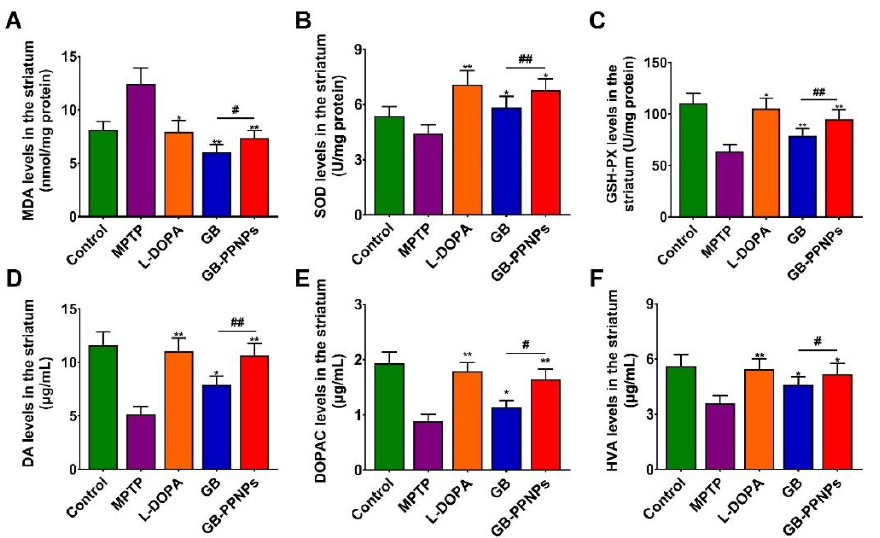
Figure 8. The impact of GB-PPNPs on striatal. The levels of ( A ) MDA, ( B ) SOD, ( C ) GSH-Px (means ± SD, n = 4), ( D ) dopamine, ( E ) DOPAC, and ( F ) HVA ( n = 7). * p < 0.05 and ** p < 0.01 corresponds to different treatments vs. MPTP . # p < 0.05 and ## p < 0.01 corresponds to GB-PPNPs vs. GB.